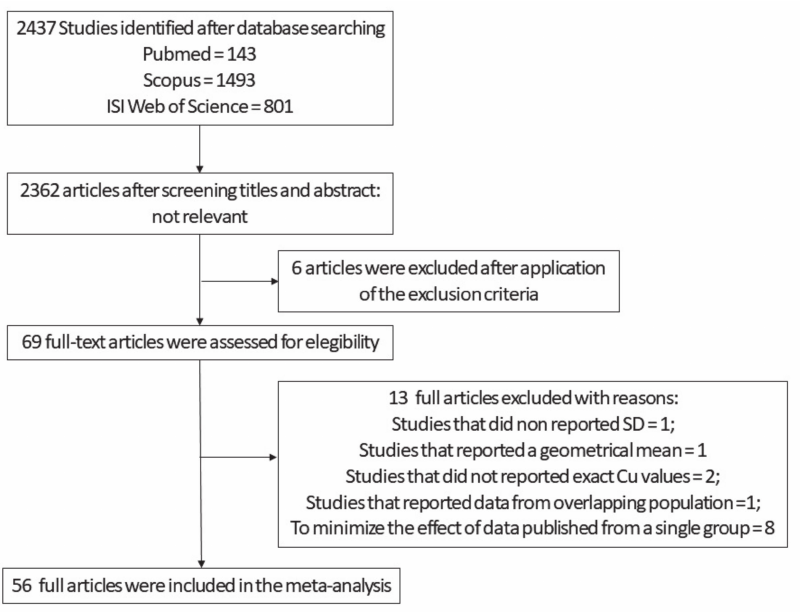
Figure 1. Flow diagram employed from the screening and selection of the analyzed Cu studies Table